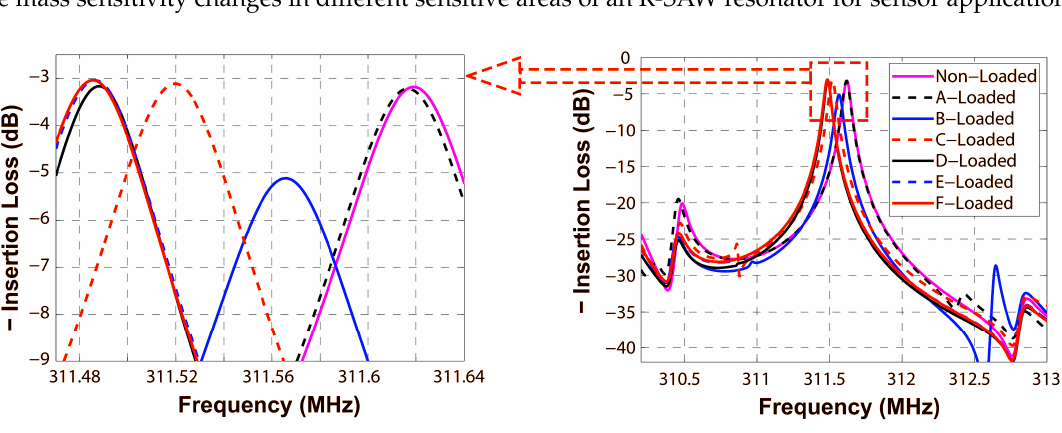
Figure 14. The frequency responses for non-loaded and different sensitive areas shown in Figure 13 with mass loaded of the resonator.